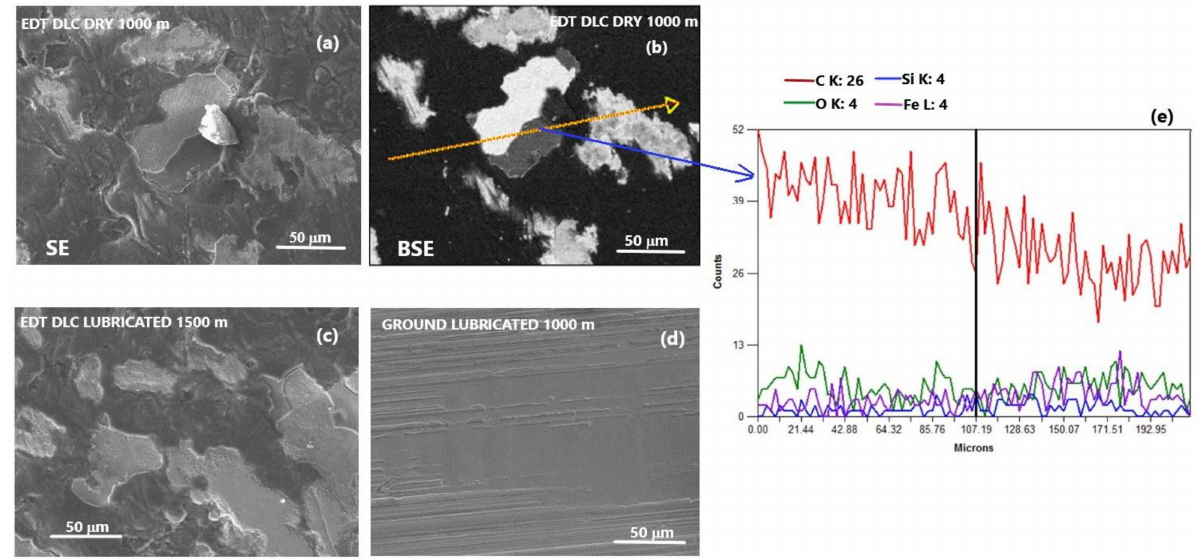
Figure 15. Wear mechanisms observed under SEM: ( a , b ) EDT DLC dry, 1000 m sliding, SE image left, BSE image right; ( c ) EDT DLC lubricated, 1500 m sliding; ( d ) ground lubricated, 1000 m sliding; ( e ) EDX composition profile along the line selected in ( b